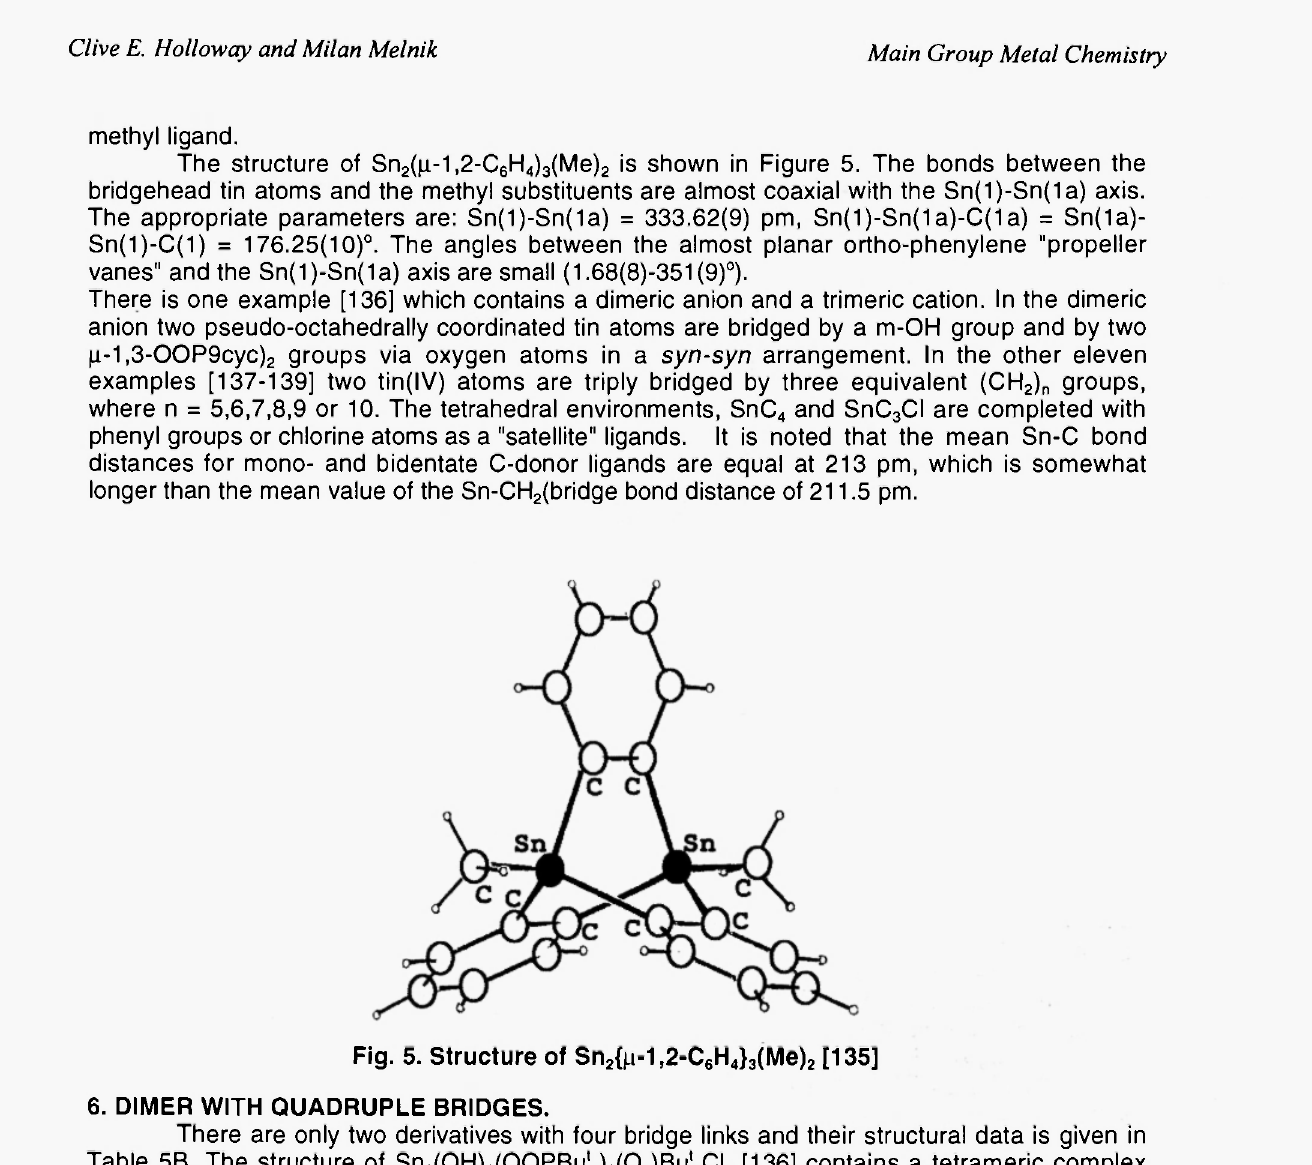
Fig. 5. Structure of Sn 2 ^-1,2-C e H 4 } 3 (Me)